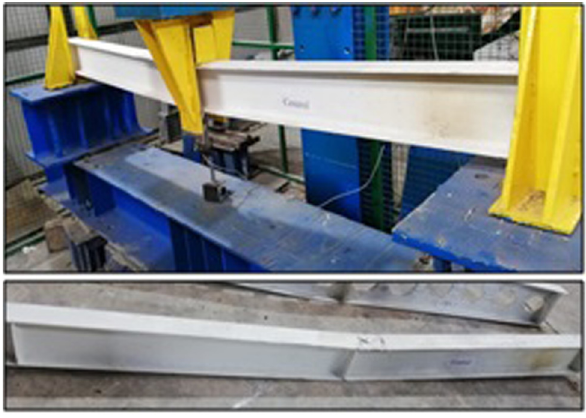
Figure 7: Failure mode of control